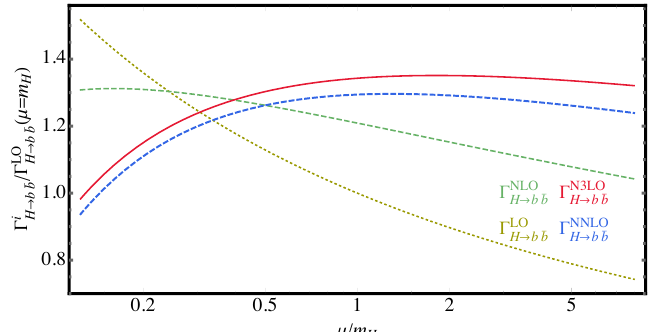
Figure 10 . Dependence on the renormalization scale (cid:22) of the inclusive H ! bb decay width up to N 3 LO accuracy (rescaled by the LO width at (cid:22) = m H ).